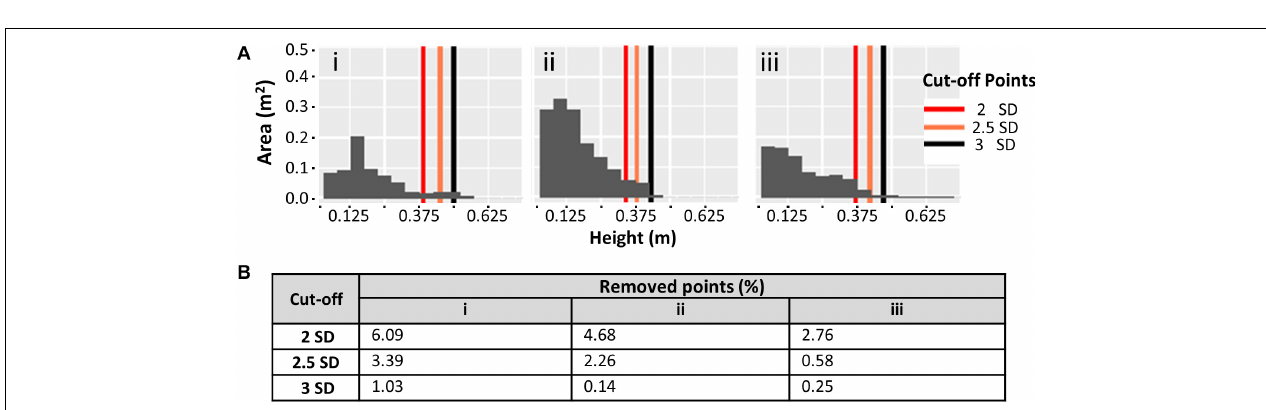
FIGURE 4 | Comparison of maximum height computed from UAV flights with proximal ground truth measurements at plot level, for pre clean up UAV data (A) , and data cleaned using cut-offs of 3 (B) , 2.5 (C) , and 2 (D) standard deviations above the mean. p < 0.01 in all cases and n = 488.